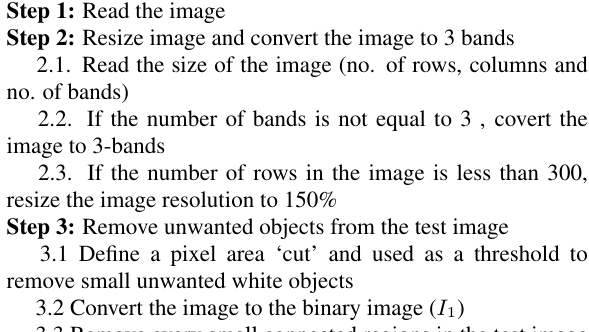
Figure 1. Proposed methodology for the architectural